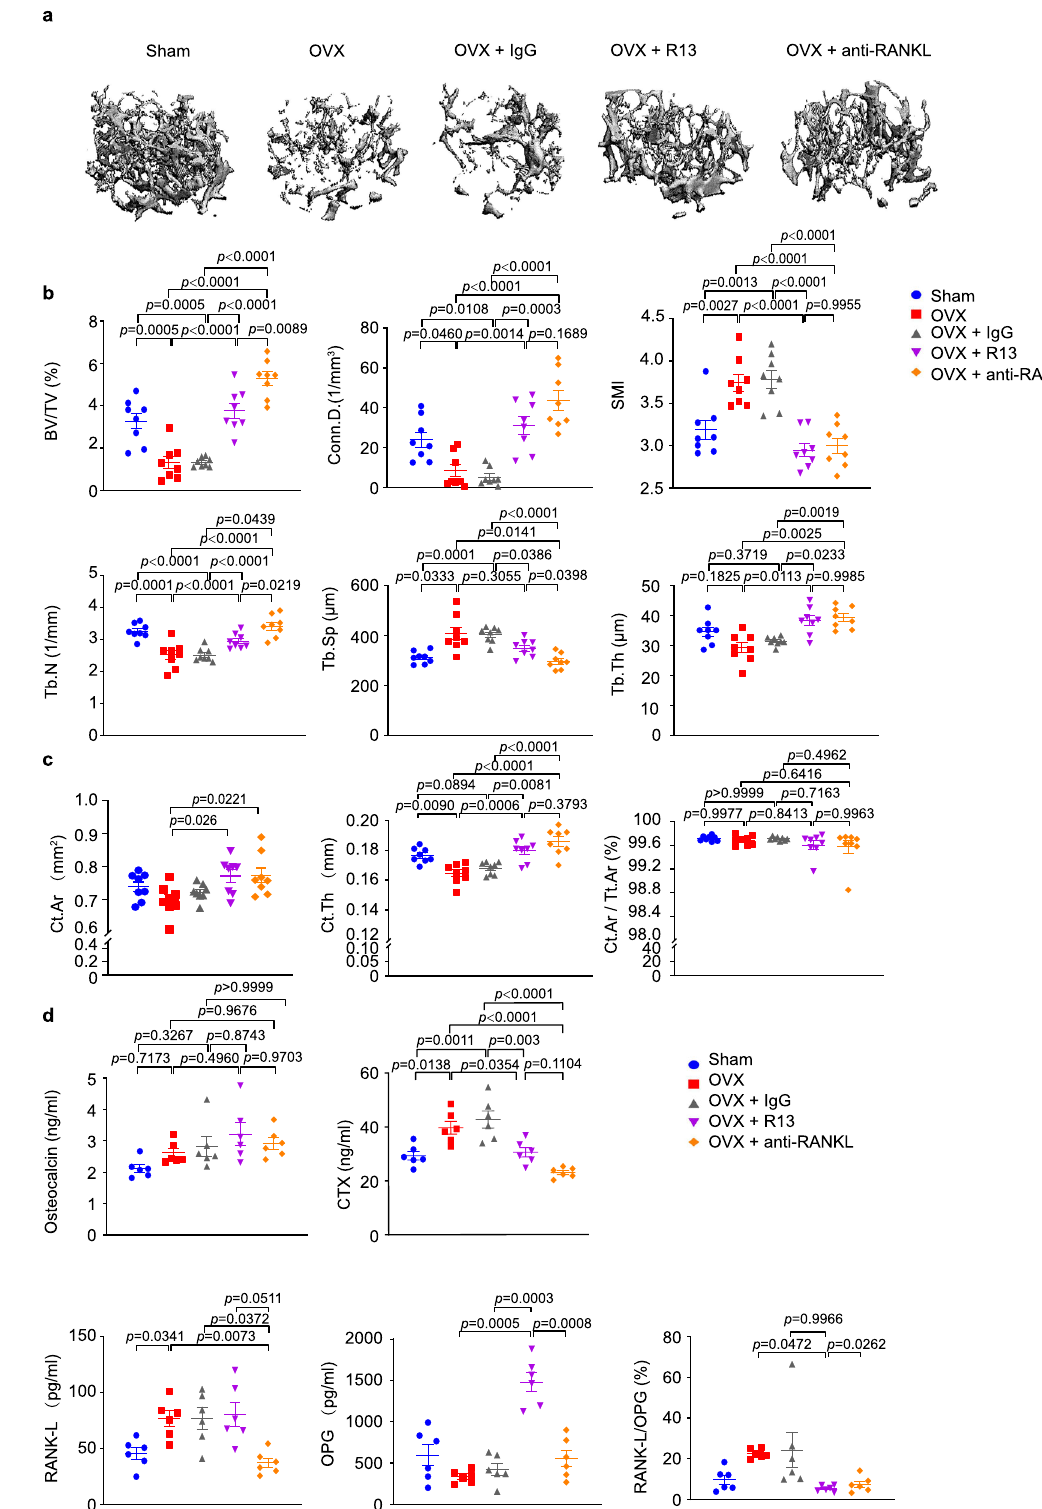
Fig. 7 | R13 and anti-Rank-L antibody treatments display the similar effect on blocking trabecular bone loss induced by ovariectomy in WT female mice. Femoral bone structures were assessed by in vitro μ CT in wild-type mice which were obtained ovariectomy at 12 weeks old, and some of which were treated with R13(21.8mg/kg,byoralgavage)oranti-RANK-Lantibody. a Representiveimagesof the femoral indices of trabecular bone structure measured by in vitro μ CT scan.